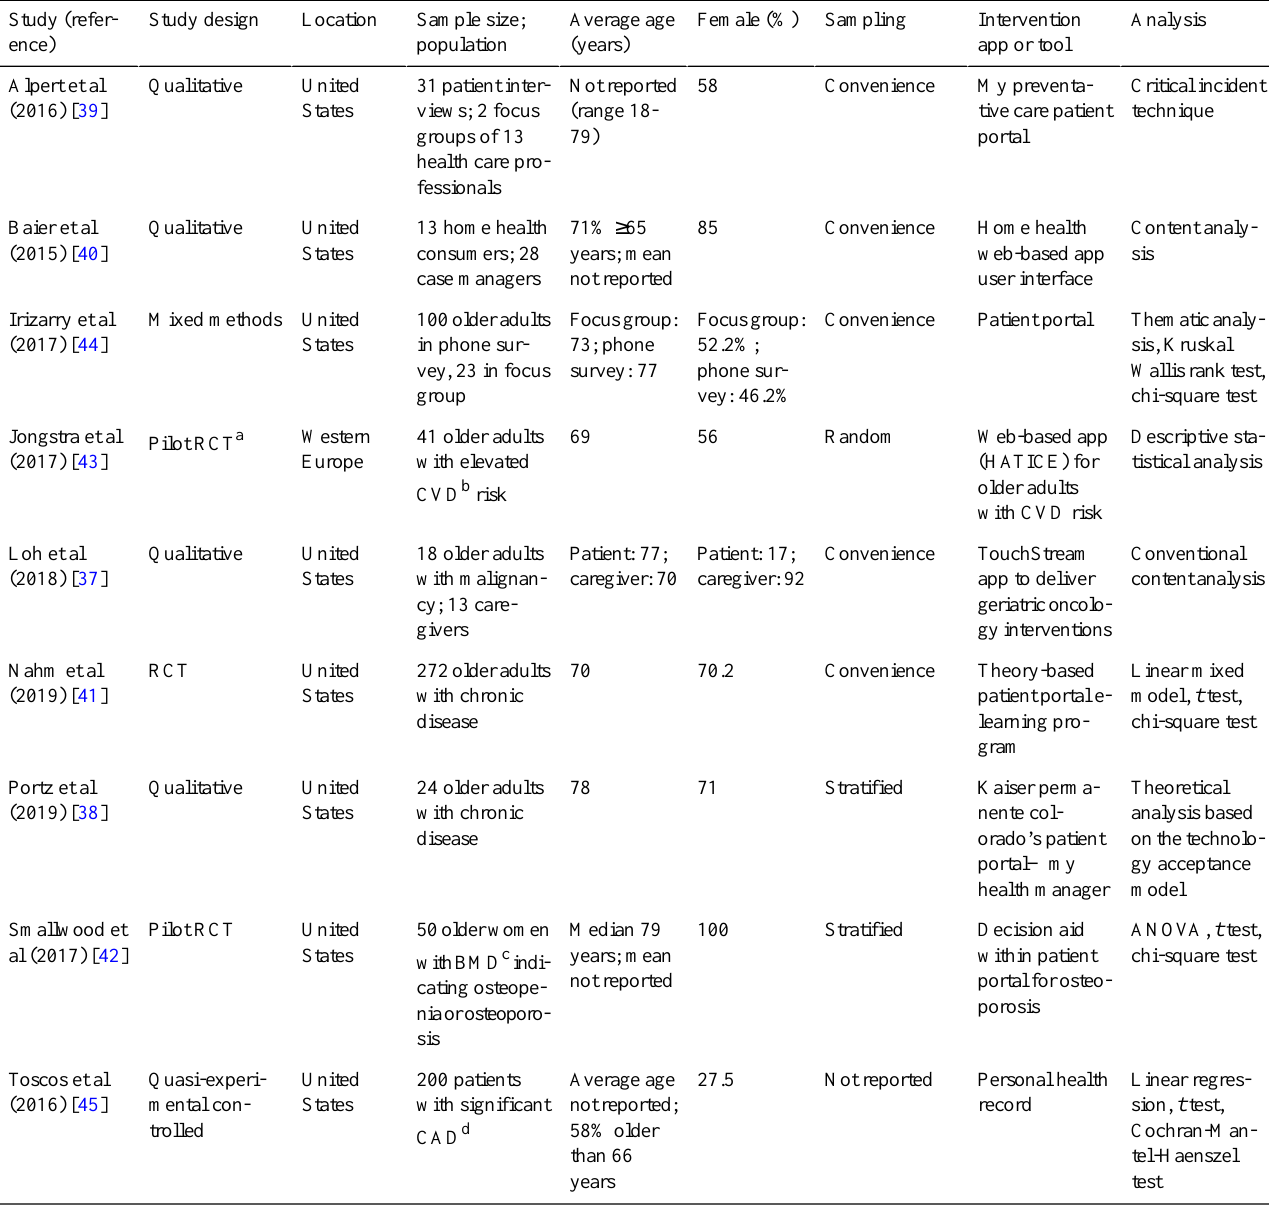
Table 1. Description of the included